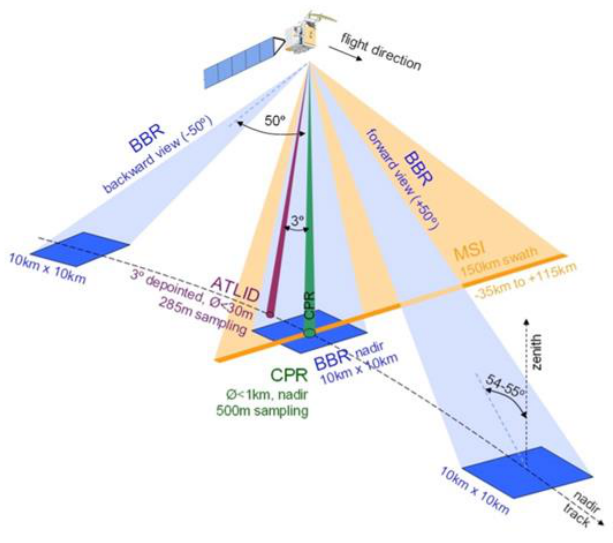
Figure 2. EarthCARE payload viewing geometry.